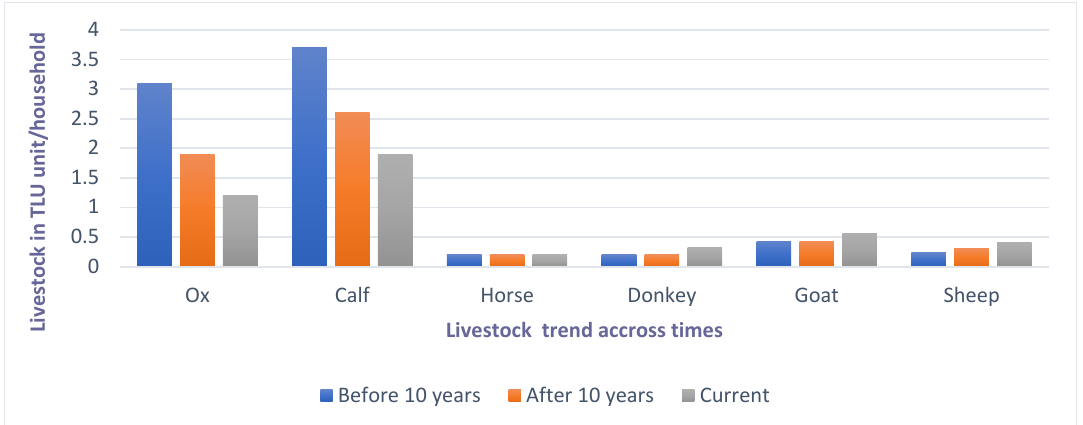
Figure 4. Impact of climate change on livestock population. Source: survey (March–May 2020). Populations of pack animals such as donkeys increased by 37%, while populations of small ruminant goats ( Capira) and sheep ( Ovis) showed increases of 30% and 78%, respectively (Figure 4). Ninety-eight percent of households perceived that climate change harms their farm